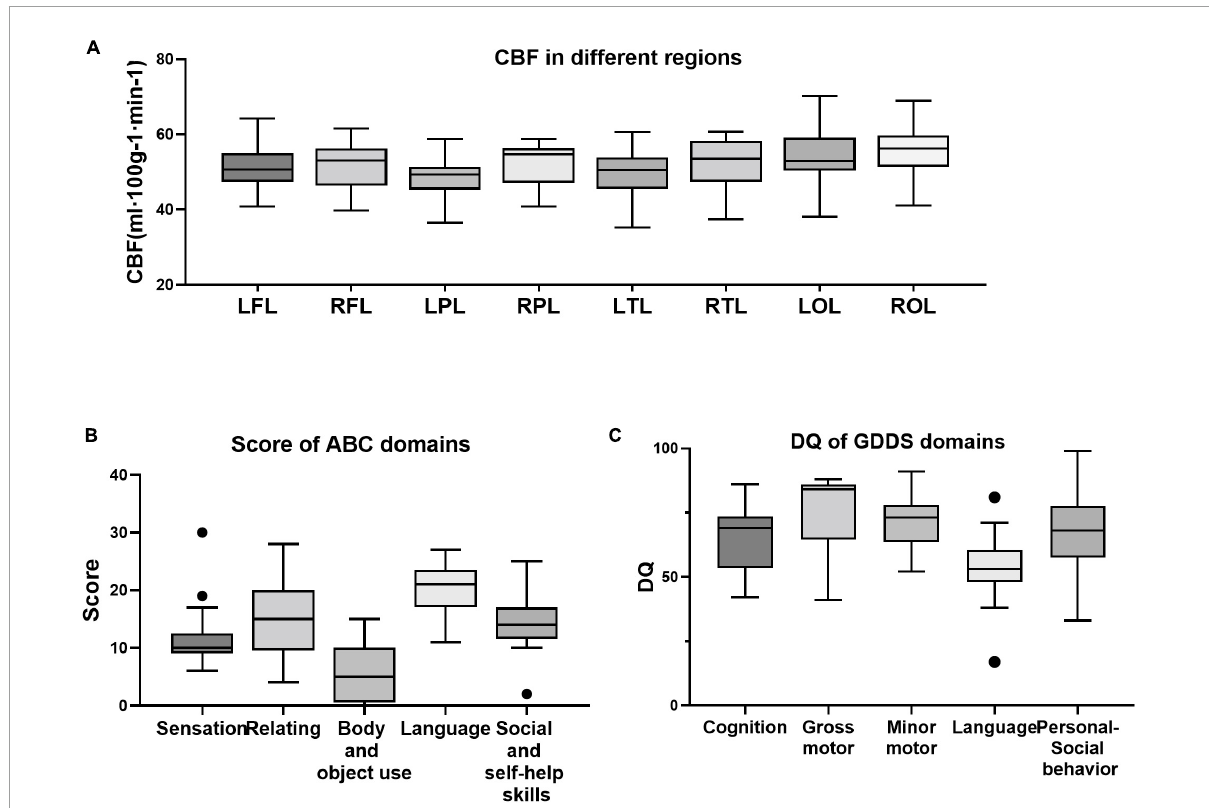
FIGURE4 Distribution of all variables of cerebral blood flow (CBF) (A) , clinical characteristics (B) , and developmental indicators (C) . Within ASD group, outliers were detected in the sensation domain score on the Autism Behavior Checklist (ABC) (B) , the social and self-help domain score on the ABC (B) , and the language domain DQ on the Gesell development diagnosis scale (GDDS) (C)